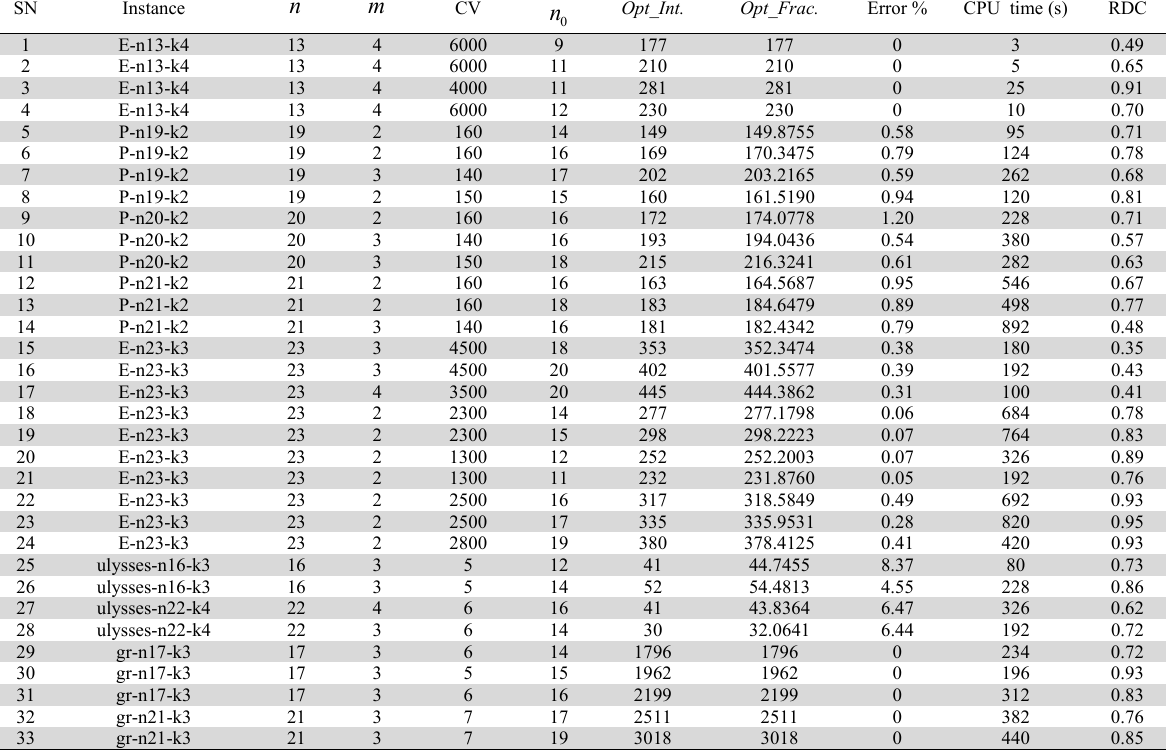
Summary computations of CTVRP over benchmark